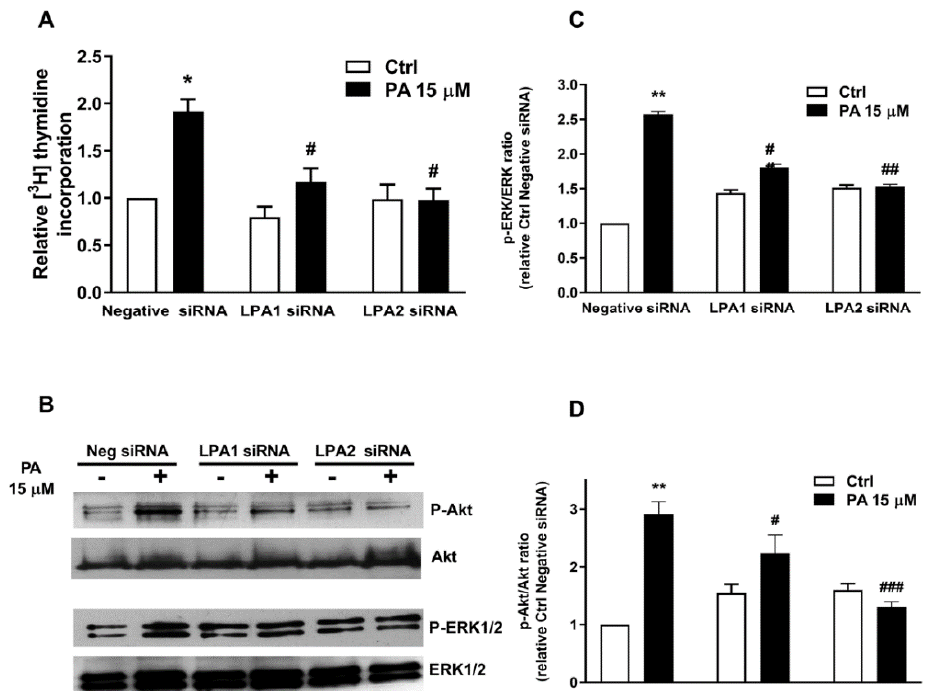
Figure 6. Implication of LPA1 and LPA2 receptors in PA-induced DNA synthesis and Akt and ERK phosphorylation. Myoblasts were preincubated for 5 h with negative (scrambled) siRNA (Neg siRNA) or with specific LPA1 or LPA2 siRNA (40 nM in all cases), as indicated. Transfected cells were maintained in DMEM with 10% fetal bovine serum (FBS) for 48 h and were then serum-starved in DMEM supplemented with 0.1% BSA for 24 h. A . Cells were treated with 15 μ M PA or vehicle for 16 h, as indicated. [ 3 H]Thymidine incorporation was measured as described in the Materials and Methods section. Results are expressed relative to the control value without agonist and are the mean ± SEM of 3 independent experiments performed in triplicate. (* p <0.05, control versus PA-treated cells, # p <0.05; PA-treated cells versus PA-treated cells in the presence of siRNA). B. Cells were treated as above and then stimulated for 5 min with 15 μ M PA or vehicle as indicated. Cell lysates were analyzed by western blotting as described in the Materials and Methods section. Phosphorylation of Akt and ERK1/2 was determined using specific antibodies to phospho-Akt (P-Akt) or phospho-ERK1/2 (P-ERK1/2). Equal loading of protein was monitored using specific antibodies to total Akt or ERK1/2. Panel B shows a representative blot of three independent experiments. C and D . Results of scanning densitometry of the exposed films. Data are expressed as arbitrary units of intensity relative to the control siRNA values in the absence of agonist (Ctrl) and are the mean ± SEM of 3 replicate experiments. (* p <0.05; ** p <0.01; control versus PA-treated cells, # p <0.05, ## p <0.01, ### p <0.001; PA-treated cells versus PA-treated cells in the presence of the corresponding siRNA, as indicated).